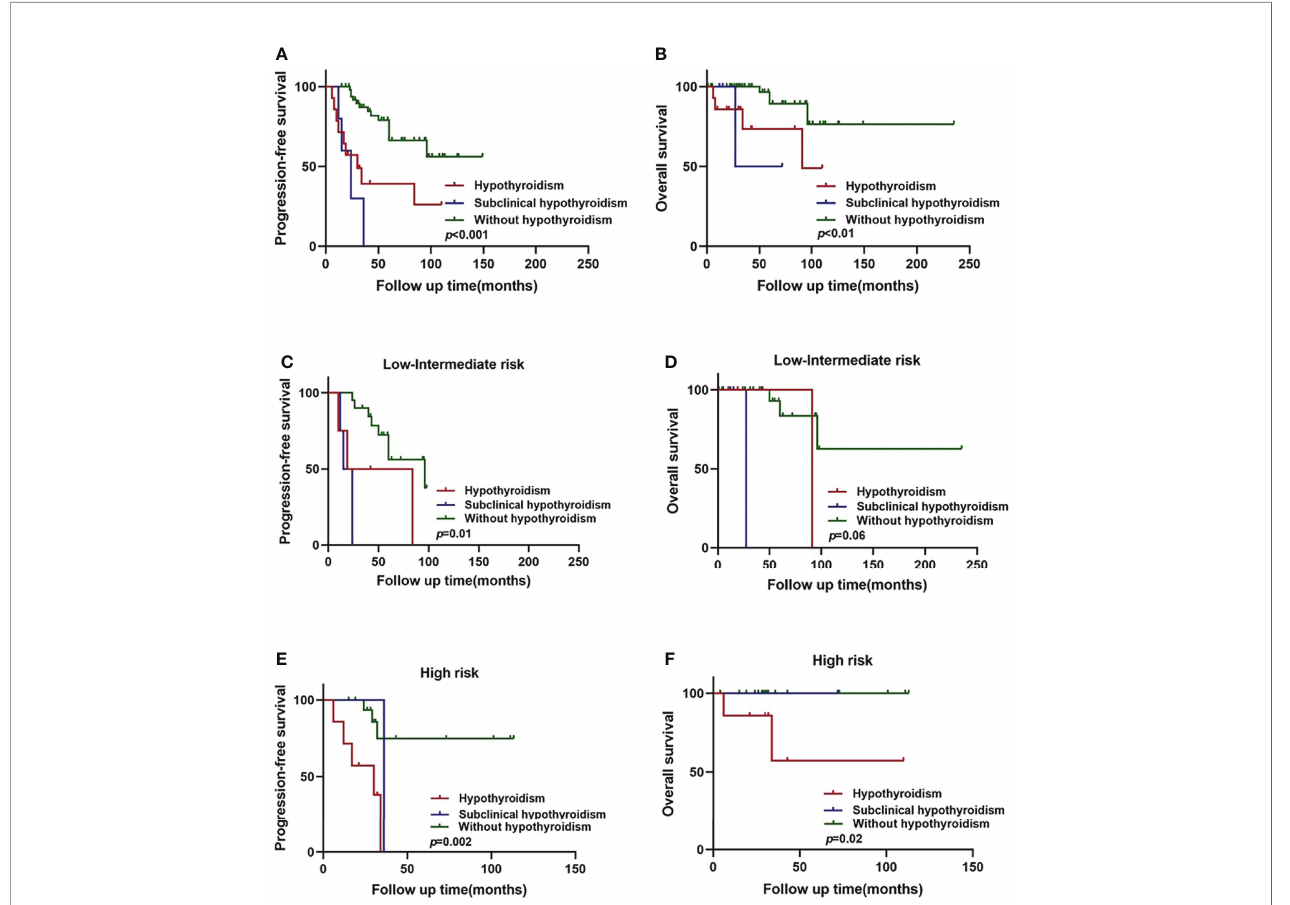
FIGURE 2 | Hypothyroidism and subclinical hypothyroidism in relation to WM/LPL survival. (A) Kaplan – Meier curves of PFS strati fi ed by hypothyroidism, subclinical hypothyroidism, and without hypothyroidism. (B) Kaplan – Meier curves of OS strati fi ed by hypothyroidism, subclinical hypothyroidism, and without hypothyroidism. (C) Kaplan – Meier curves of PFS strati fi ed by hypothyroidism, subclinical hypothyroidism, and without hypothyroidism in low-intermediate risk group. (D) Kaplan – Meier curves of OS strati fi ed by hypothyroidism, subclinical hypothyroidism, and without hypothyroidism in low-intermediate risk group. (E) Kaplan – Meier curves of PFS strati fi ed by hypothyroidism, subclinical hypothyroidism, and without hypothyroidism in high-risk group. (F) Kaplan – Meier curves of OS survival strati fi ed by hypothyroidism, subclinical hypothyroidism, and without hypothyroidism in high-risk